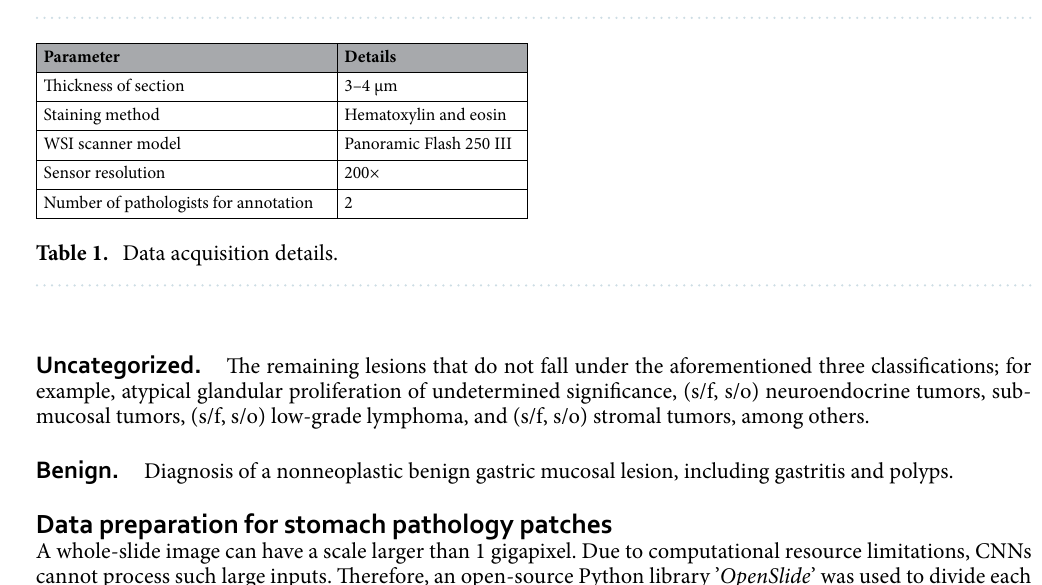
Figure 2. Example of hematoxylin and eosin-stained raw (left) and annotated (right) whole-slide images.